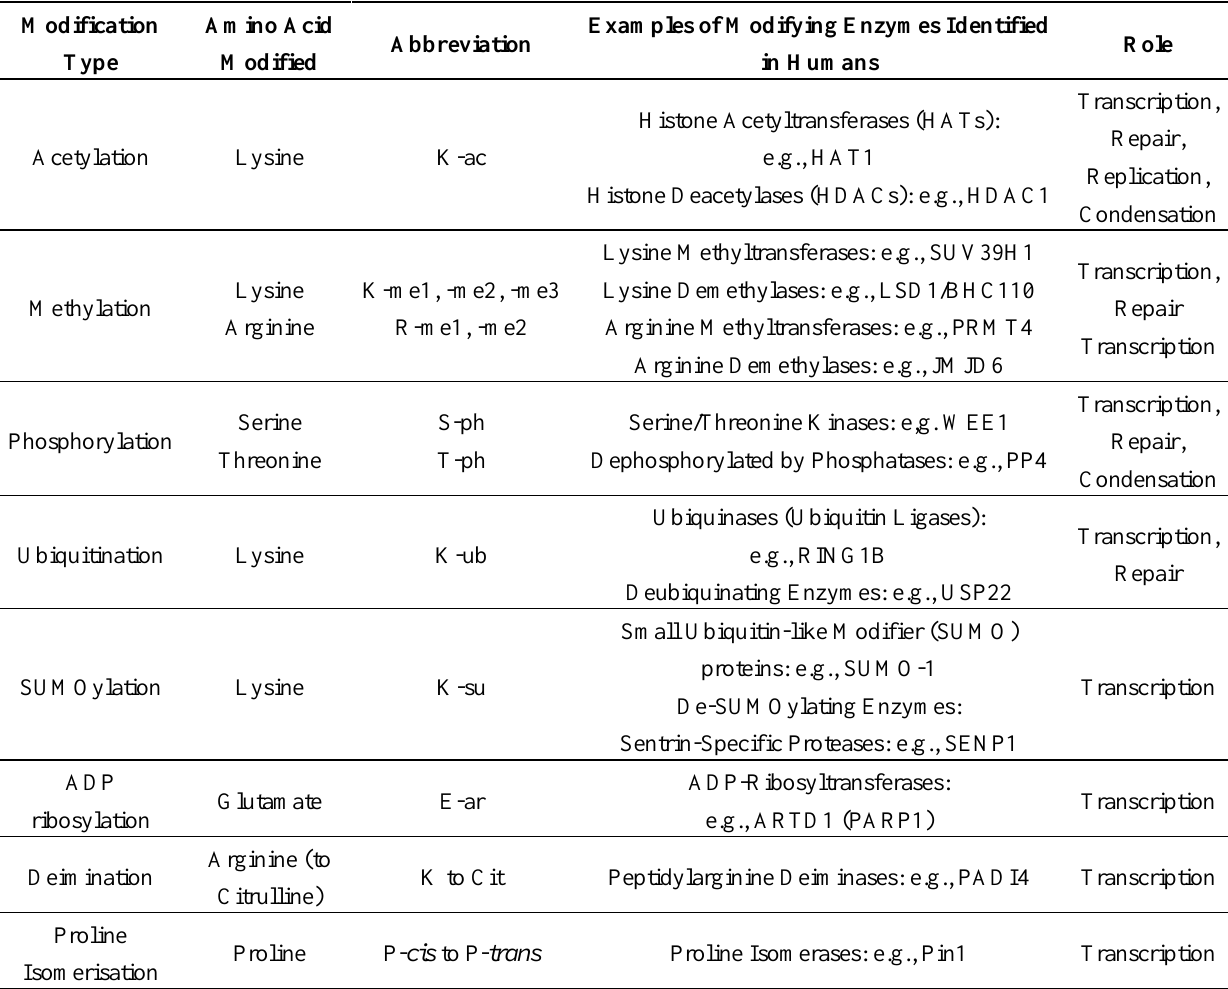
Table 1. Types of histone modifications and the enzymes responsible (adapted from